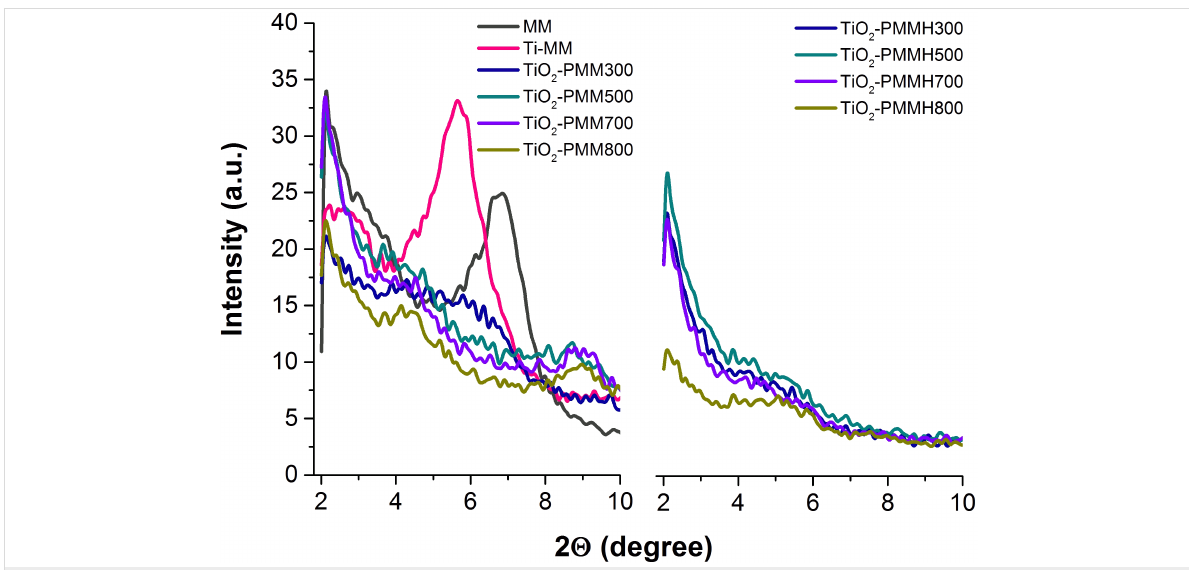
Figure 1: Small-angle XRD patterns of the raw MM, Ti-MM, TiO 2 -PMM х , and TiO 2 -PMMH х (see Experimental section for abbreviations).